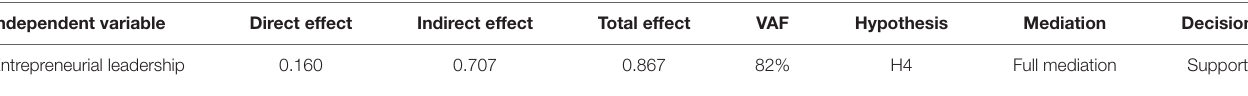
TABLE 5 | Mediating